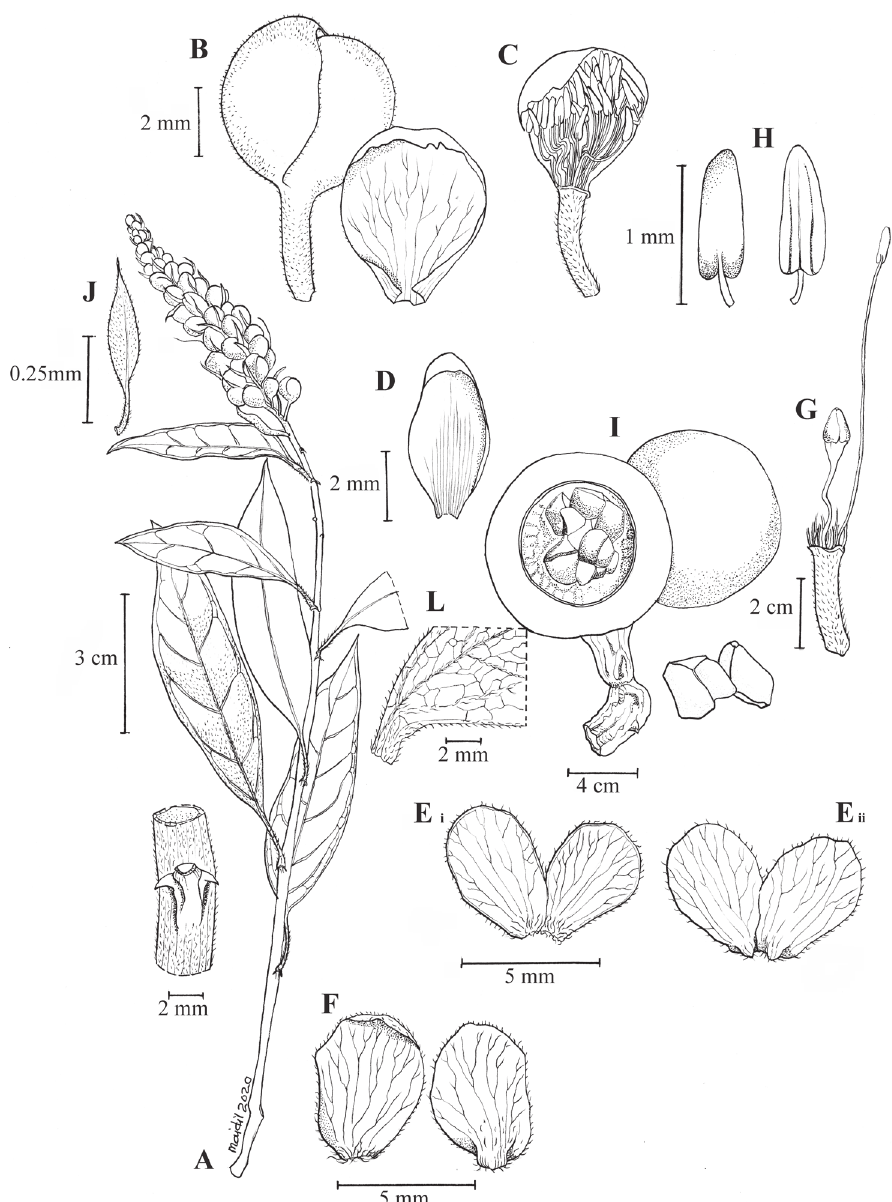
Figure 5. Capparis scortechinii var. ruthiae Julius, var. nov. A flowering (bud) leafy twig with stipular thorns close-up next to it B flower bud close-up C flower bud with sepals and petals removed exhibiting the stamens D adaxial view of outer sepal (upper) and inner sepal (below) E dorsal petals, adaxial view (i) and abaxial view (ii) F ventral petals, exhibiting adaxial with hairs at base (left) and abaxial view (right) G flower bud dissected exhibiting one elongated stamen and the ovary on gynophore H anther, front (right) and back view (left) I fruit in cross-section and seeds (below) J an unguiculate leaf-like bract K venation close-up. (Drawn by Mohamad Aidil Noordin from Kiew RK 3747 [ A–H, J, L ] and from Henderson 23551 [ I ]: the scale for C is similar to B